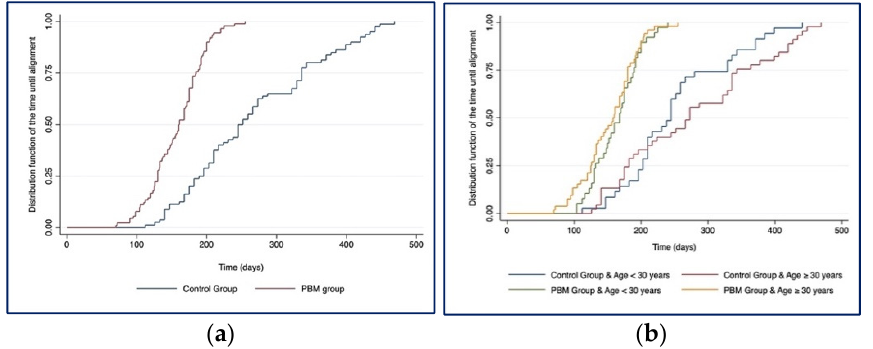
Figure 4. Kaplan–Meier Failure Function. ( a ) Median PBM: 160 days (95%CI: 148; 172), Median Con-